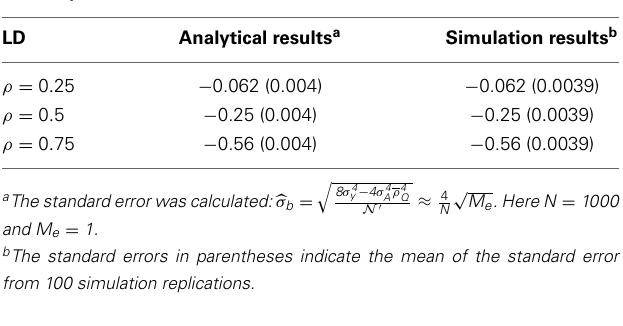
Table 8 | The sample size required for the single-marker HE regression to detect a QTL associated with the target marker.